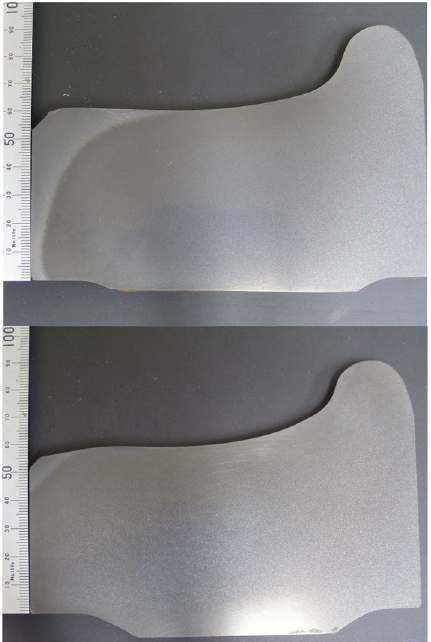
Fig. 6 Macro-section of a Class C wheel etched by Nital showing mixed pearlite/bainite structure at the front face rim corner indentified as lighter colour in contrast with darker pearlitic